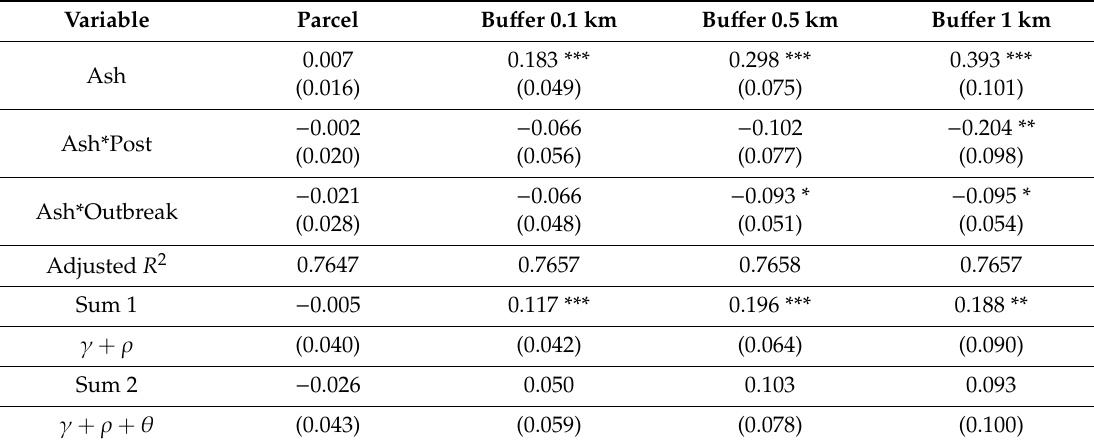
Table 5. Coe ffi cient Estimates of Hedonic Model 3 for Ash and emerald ash borer (EAB) variables,